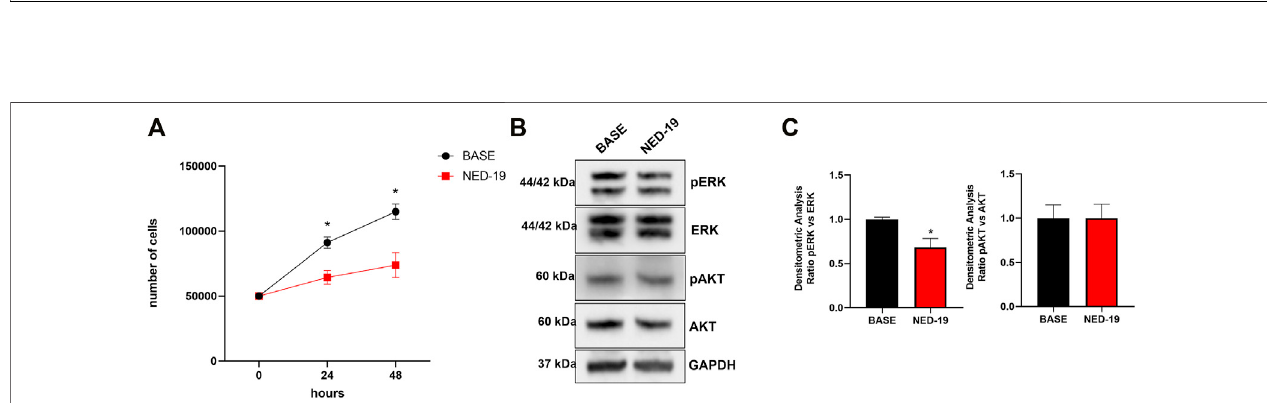
FIGURE 8 | TPCs mediate 20% FBS-induced proliferation and ERK phosphorylation in C-MSCs. Following 4 h of growth without serum, cells were treated with NED-19(100 μ M,30 min)andsubsequentlystimulatedwith20%FBS. (A) Following24and48 hofFBSstimulation,themediumwasremoved,cellsdetachedfromthe plates, and counted by hemocytometer ( n = 3/group). Student ’ s t-test: *p < 0.05. (B) The cells were lysate after 60 min of FBS stimulation. Total protein extract from treated cells was subjected to Western blot analysis to visualize active phosphorylated form and total ofERK and AKT using speci fi c antibodies. Phospho-ERK1/2 and Phospho-AKT levels were corrected by total ERK1/2 and AKT densitometry respectively. (C) Western blot data are presented as the fold change of target protein expression. The results are expressed as mean ± SEM ( n = 3/group). Student ’ s t-test: *p < 0.05.